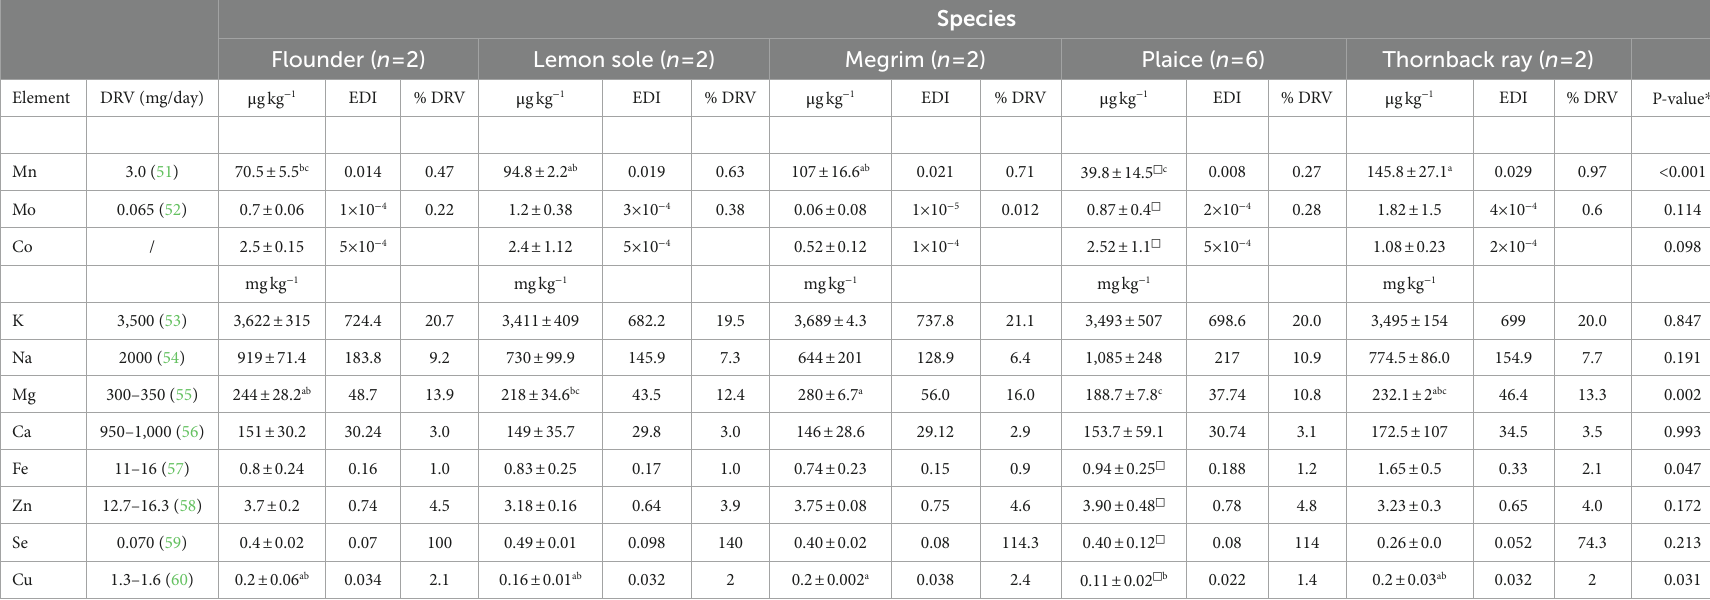
TABLE 5 Essential elements and nutritional contribution of a 200 g portion of fillet of flounder, lemon sole, megrim, plaice, and thornback